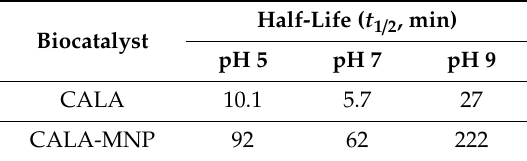
Table 2. Half-life for CALA and CALA-MNP at 85 ◦ C and pHs 5, 6 and 9. Table 2. Half‐life for CALA and CALA‐MNP at 85 °C and pHs 5, 6 and 9. Biocatalyst